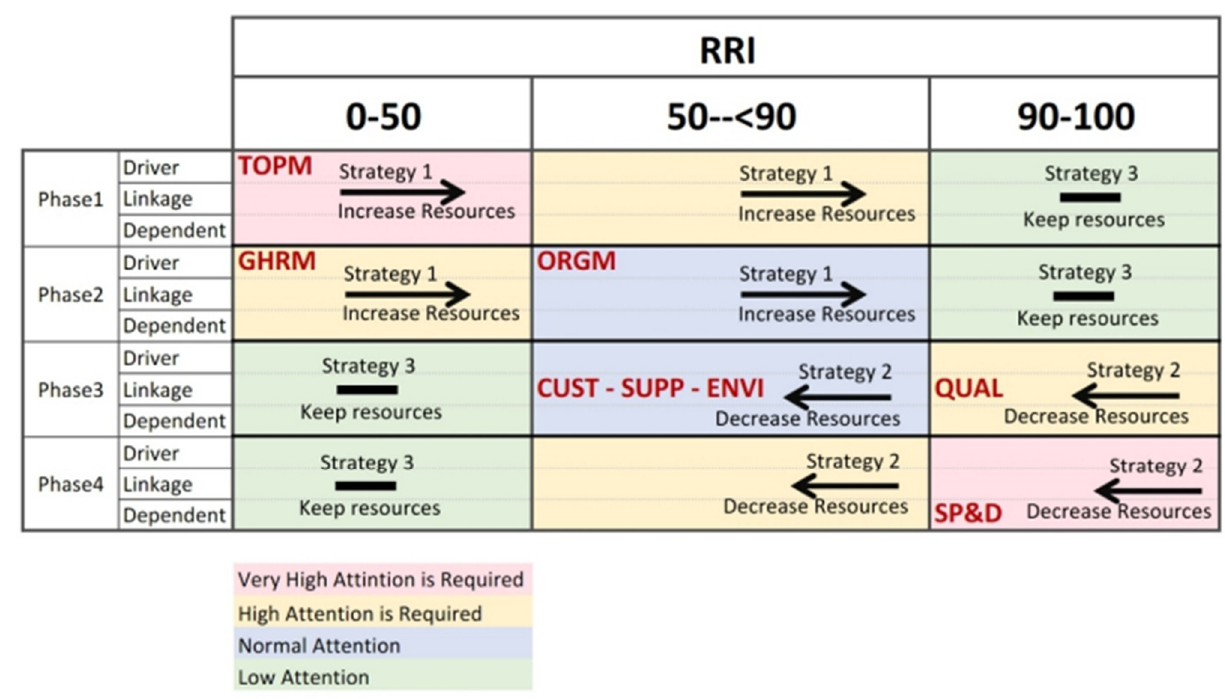
Figure 9. Proposed strategic matrix tool.